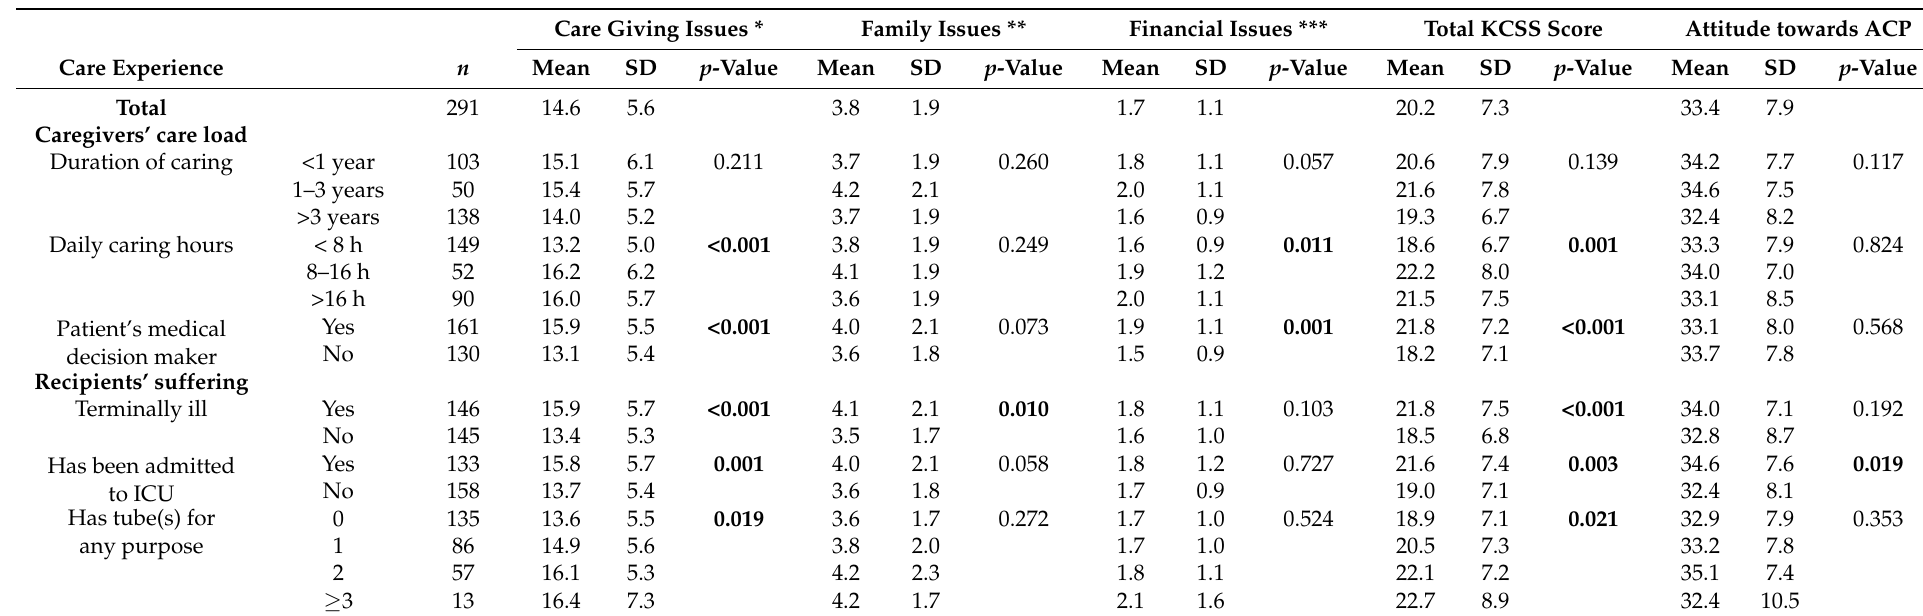
Table 3. The relationship between the caregivers’ care experience and stress and their attitude towards ACP. Care Giving Issues